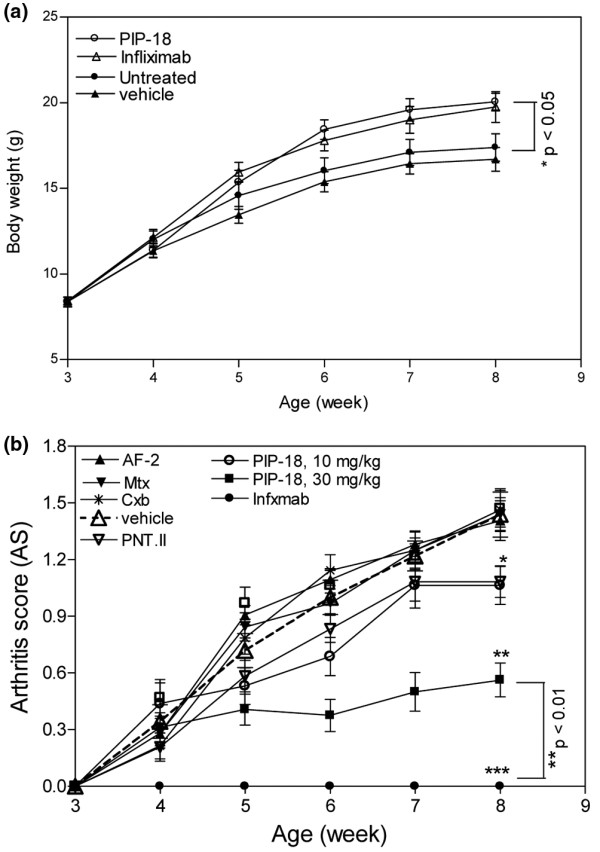
Beneficial effects of PIP-18 on disease outcome. Intraperitoneal injections commenced at age three weeks and terminated at eight weeks. Body weights were recorded before and weekly after injections. (a) Tg197 mice injected with phospholipase inhibitor from python (PIP)-18 (30 mg/kg) or infliximab (10 mg/kg) significantly (*P < 0.05, vs untreated) gained body weights at eight week. Drugs without effect are not shown. (b) Low dose (10 mg/kg) of peptides shows effect at eight weeks, while the higher dose of PIP-18 (30 mg/kg) or infliximab (10 mg/kg) effectively reduced arthritis score (AS) at six weeks. AS was significantly reduced at eight weeks in the ankle joints of mice treated with 10 mg/kg of P-NT.II or PIP-18 (*P < 0.05 vs untreated), and 30 mg/kg of PIP-18 (**P < 0.01, vs untreated) or 10 mg/kg of infliximab (***P < 0.001, vs untreated). Data are mean ± standard error of the mean of 16 joints per group (One-way analysis of variance with Bonferroni's multiple comparison test).